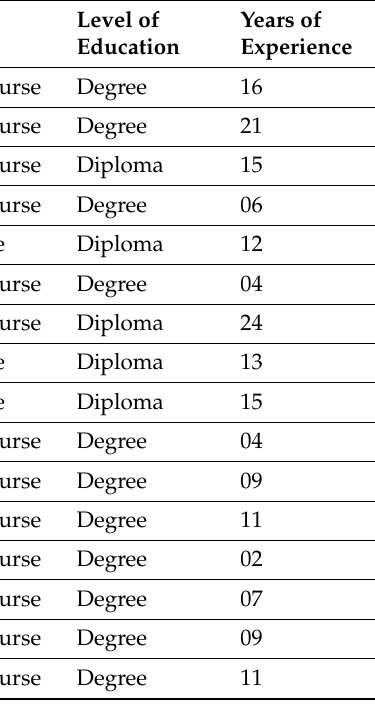
Table 1. Biographical information of healthcare